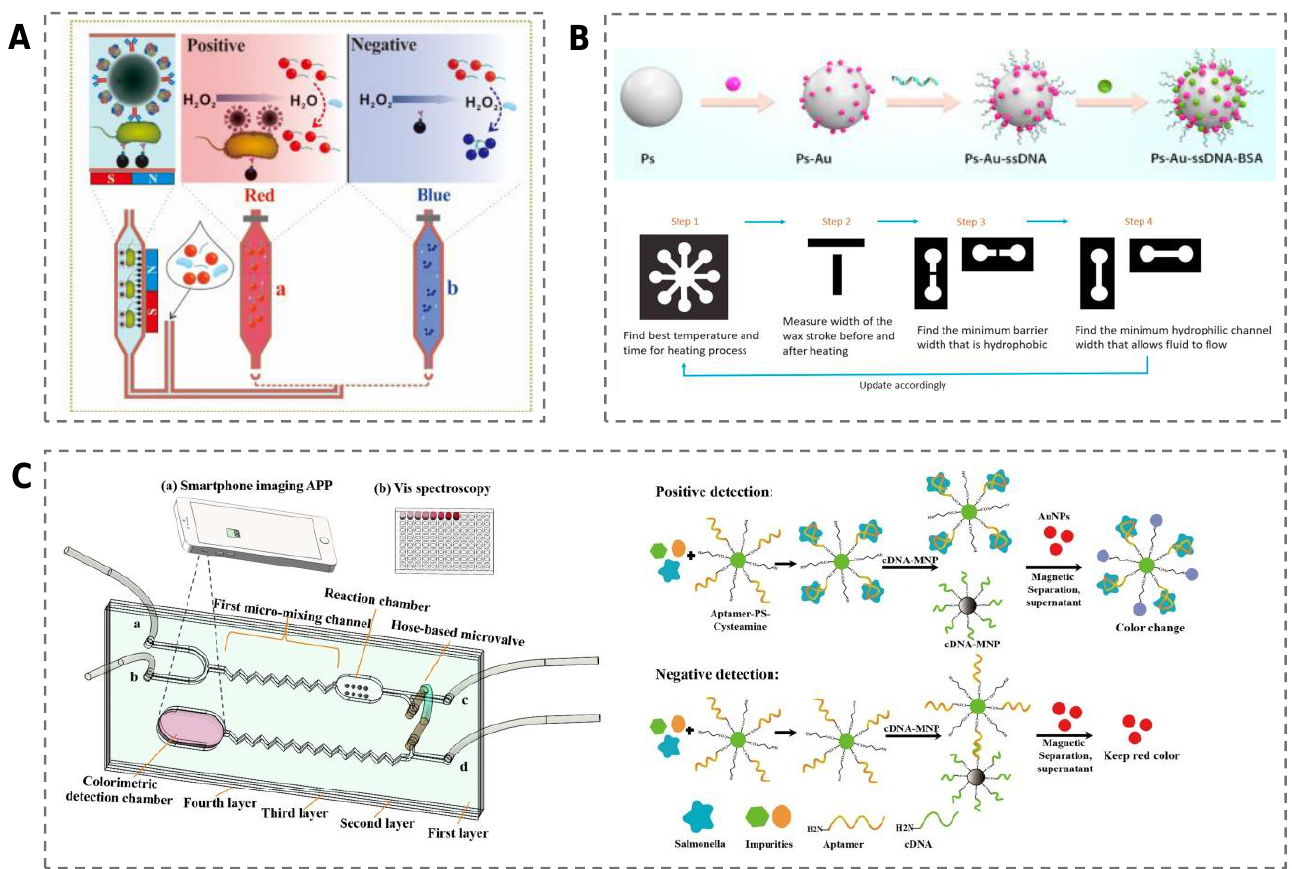
Figure 5. Colorimetric microfluidic chips based on functionalized AuNPs for pathogen detection. ( A ) A microfluidic colorimetric biosensor based on AuNP aggregation for E. coli O157:H7 detection. Reproduced with permission [96]. Copyright 2019, Elsevier. ( B ) A novel paper-based colorimetric microfluidic device for the simultaneous detection of E. coli O157:H7 and S. Typhimurium based on PS – Au – ssDNA – BSA microparticles. The 3 D structural of the designed microfluidic chip is shown on the left of figure. The specific recognition mechanism based on AuNPs is shown on the right of figure. Reproduced with permission [97]. Copyright 2022, Elsevier. ( C ) A microfluidic colorimetric strategy for the detection of S. typhimurium by using SH – PSs to aggregate AuNPs. Reproduced with permission [98]. Copyright 2021, Elsevier.